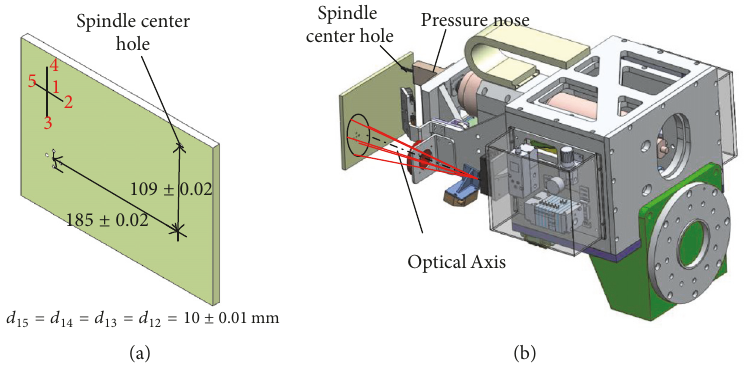
Figure 2: Visual system calibration